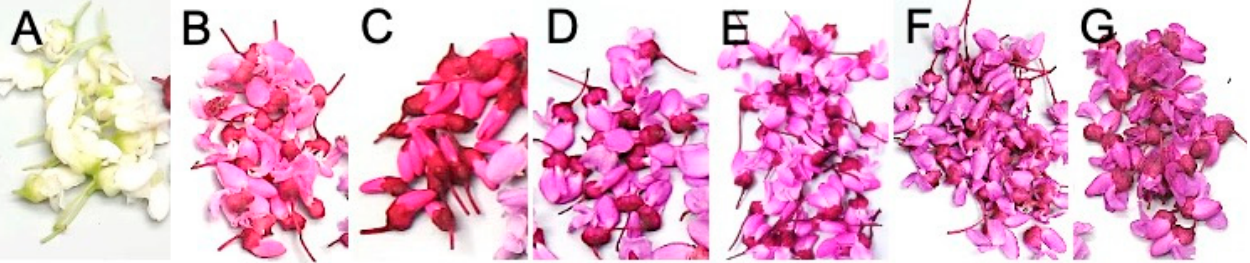
Figure 1. Flowers of C. canadensis cultivars or genotypes: ( A ) ‘var alba’ (white-type), ( B ) ‘Crosswick’s Red’ (red-type), ( C ) ‘Appalachian Red’ (red-type), ( D ) ‘Traveller’ (purple-type), ( E ) ‘Ruby Falls’ (purple-type), ( F ) ‘Forest Pansy’ (purple-type), and ( G ) ‘Oklahoma’ (purple-type). Eastern redbud flower color is linked with anthocyanin pigment composition of the floral parts, including calyx, petiole, banner, wings, and keel [10]. In previous research, nine anthocyanin pigments in redbud flowers were identified in 12 cultivars/genotypes using high-performance liquid chromatography (HPLC) [10]. Among the tested cultivars, the white-type flowers showed absent or deficient content of the nine anthocyanins in their flowers [10] and had been reported as a recessive gene [11]. The red-flowered redbud cultivars were dominant in malvidin 3,5-diglucoside and the purple-flowered cultivars were dominant in both cyanidin 3-glucoside and malvidin-3-glucoside. Both malvidin-3- glucoside and peonidin-3-glucoside were detected in all purple-type and red-type flowers but amounts as a percent of total anthocyanins were significantly lower in flower tissue of red-type cultivars (0 to 1.1%) than in purple-type cultivars (1 to 19.7%) [10]. Redbud leaf petioles often show visible pink to purple color, even in seedlings (Figure 2), indicating the potential presence of anthocyanin pigments. Anthocyanin profiles of petioles could be a physiological marker for flower color-type breeding in early selection if different flower color-type plants show unique anthocyanin profiles as is found in floral tissue. A selection based on petiole tissue instead of flower color could significantly increase the efficiency of the breeding process because petiole tissue is available most of the year from the seedling to the adult phases. To investigate the potential of using the anthocyanin content of the petiole as a physiological marker for flower color, anthocyanin profiles of petiole tissue for different flower color-types are needed. Understanding the relationship between petiole anthocyanin profile and the flower color is critical for developing the physiological marker to predict flower color for Cercis Breeding. In this study, peonidin-3-glucoside and malvidin-3-glucoside content in petiole tissues of 14 cultivars and 22 progenies of ‘Appalachian Red’ (red-type) × ‘Oklahoma’ (purple-type) with segregated flower color-types were determined by HPLC. The relation- ship of anthocyanin content to flower color-type type and leaf color of tested plants was also